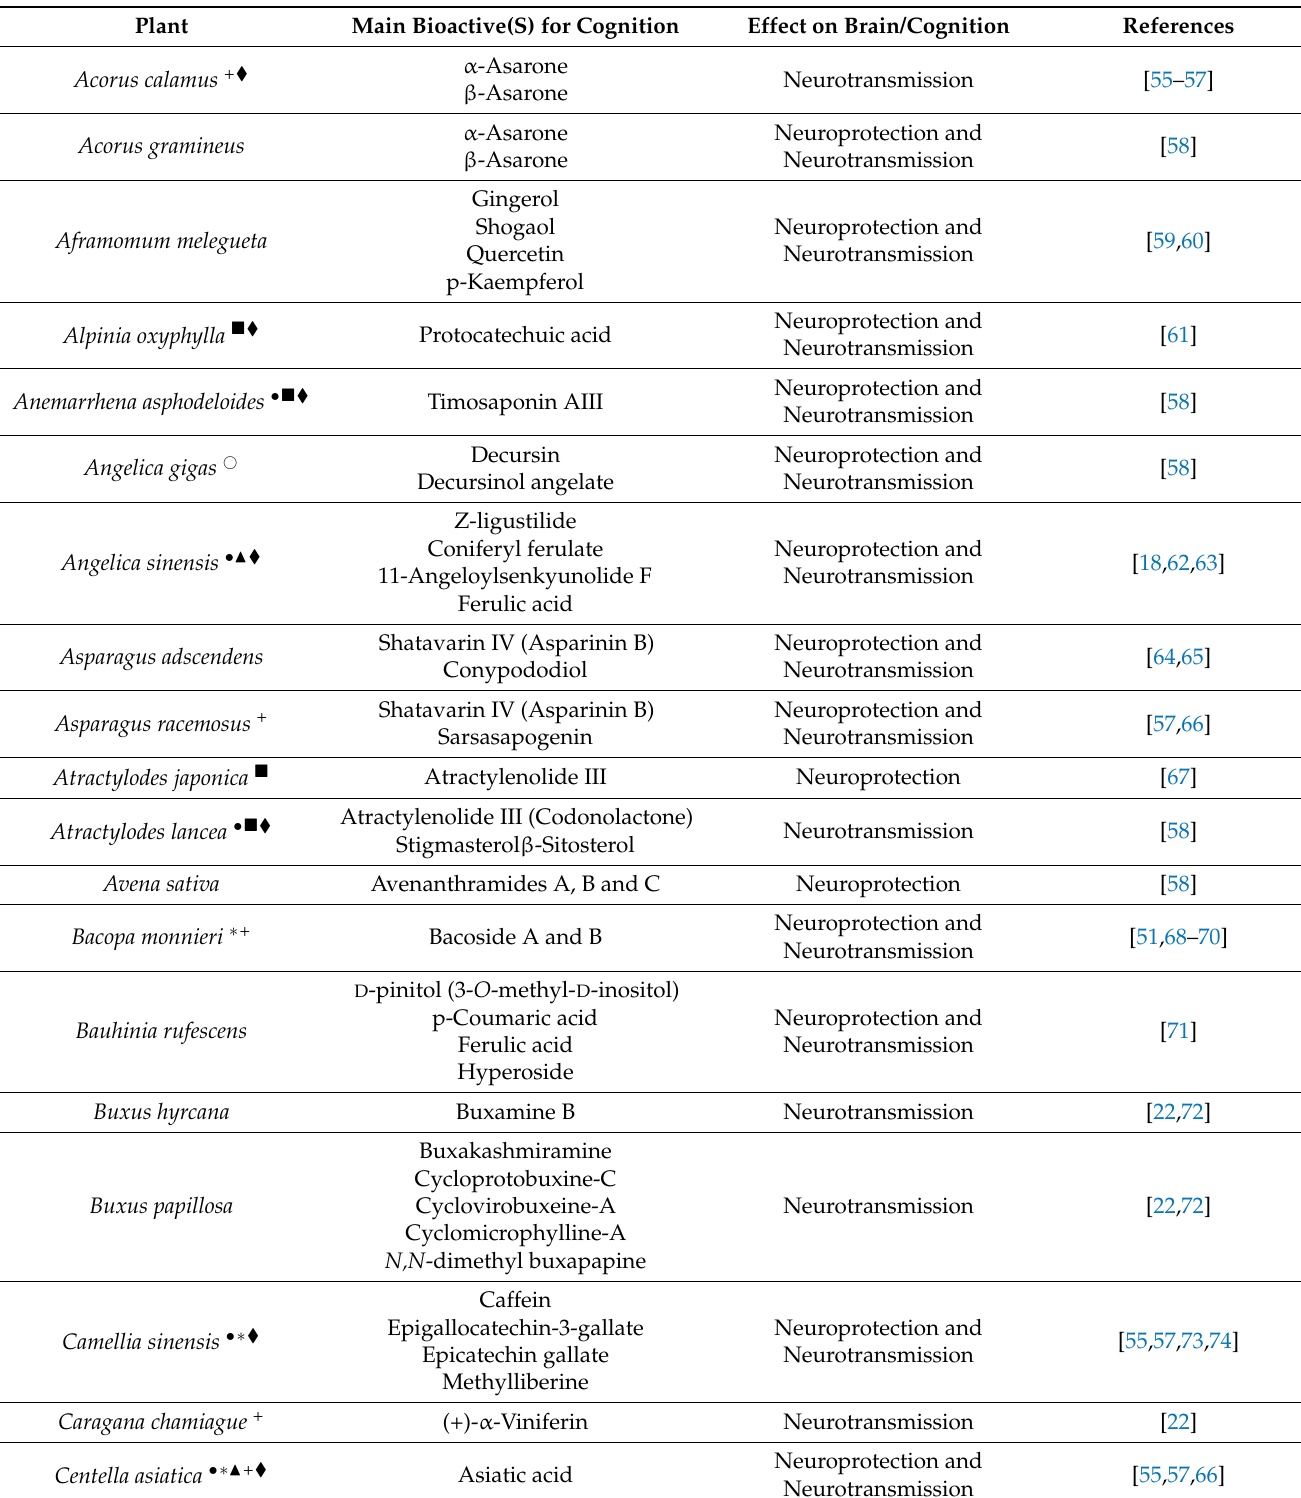
Table 1. Characterization of the plants purported as acting as cognition enhancers and main mechanism(s) of action. Bioactive molecules were selected based on reported activity in cognition; other phytochemicals present in the plant were